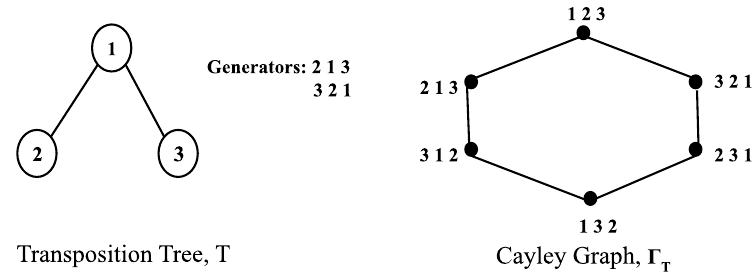
Figure 1. A Transposition tree T and the corresponding Cayley graph Γ T